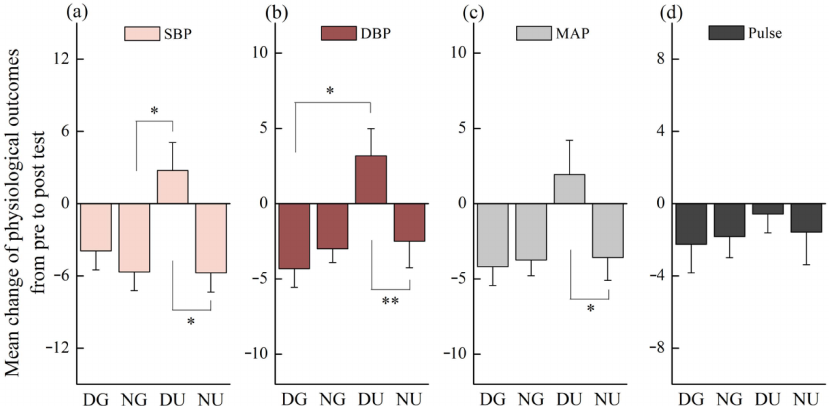
Figure 10. The physiological changes of walking in different scenarios. The ( a ), ( b ), ( c ), and ( d ) represent changes in SBP, DBP, MAP, and pulse rate respectively. The DG, NG, DU, and NU represent daytime green walking, nighttime green walking, daytime urban walking, and nighttime urban walking, respectively. The error bar represents standard error, * represents p < 0.05, and ** represents p < 0.01. Analyzed using the Kruskal–Wallis test ( N = 12).